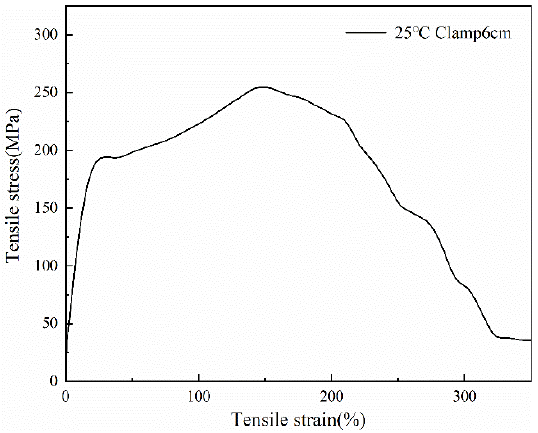
Figure 8. The stress-strain curve at 6 cm clamped at 25 °C. The average stress-strain curves of the PCTF at different temperatures are given in Figure 9; all the PCTF demonstrated the typical stress-strain curve of conventional fiber, and had similar trends.